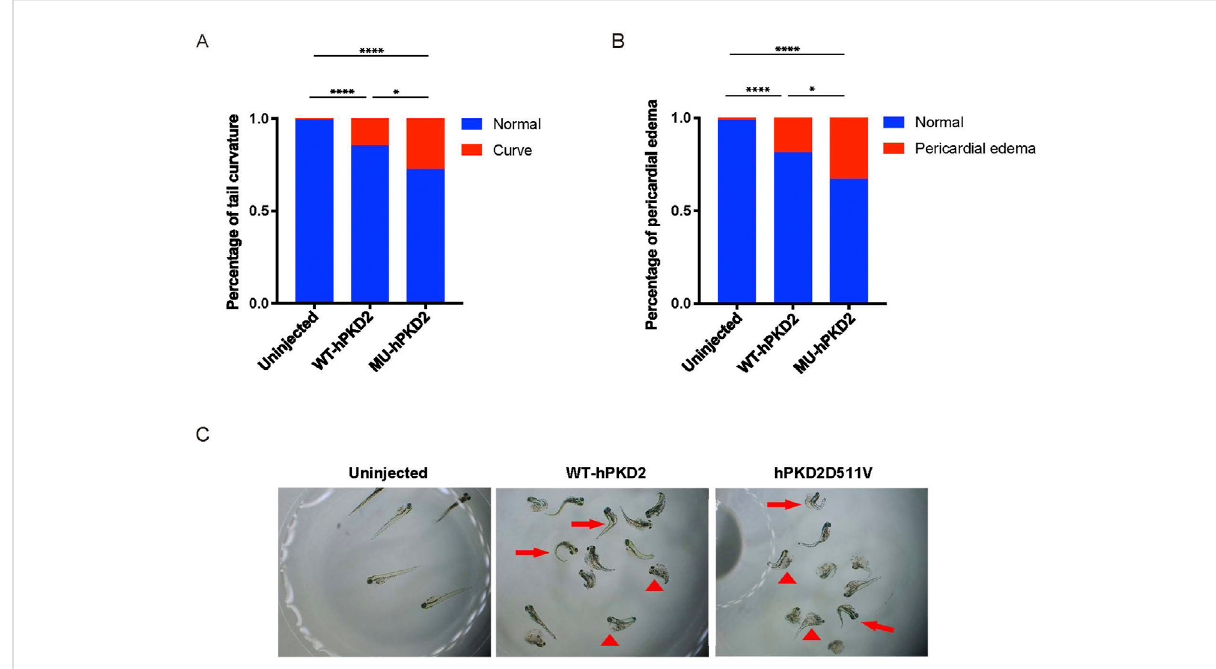
FIGURE 1 Overexpressionof hPKD2-D511V resultedintailcurvatureofzebra fi sh. (A) Statisticalanalysisofthepercentageoftailcurvaturezebra fi shshows a more severe phenotype in zebra fi sh injected with the pCAG-MU-hPKD2. (B) Statistical analysis of the percentage of pericardial edema zebra fi sh. (C) The morphological observation of zebra fi sh with pCAG-MU-hPKD2 and pCAG-WT-hPKD2 injection. The arrows indicate tail curvature, and the arrowheads indicate pericardial